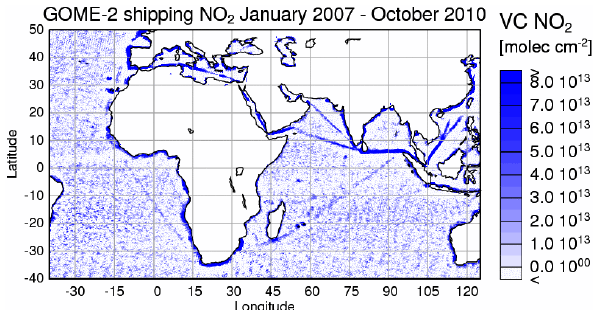
Fig. 13. Long-term average of tropospheric NO 2 columns derived from the improved GOME-2 NO 2 data set. Data have been spatially high pass filtered to highlight the signals from ship emission. See text for